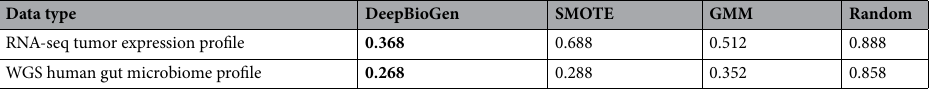
Table 1. H -divergence between source and test data. The bolded value indicates the smallest